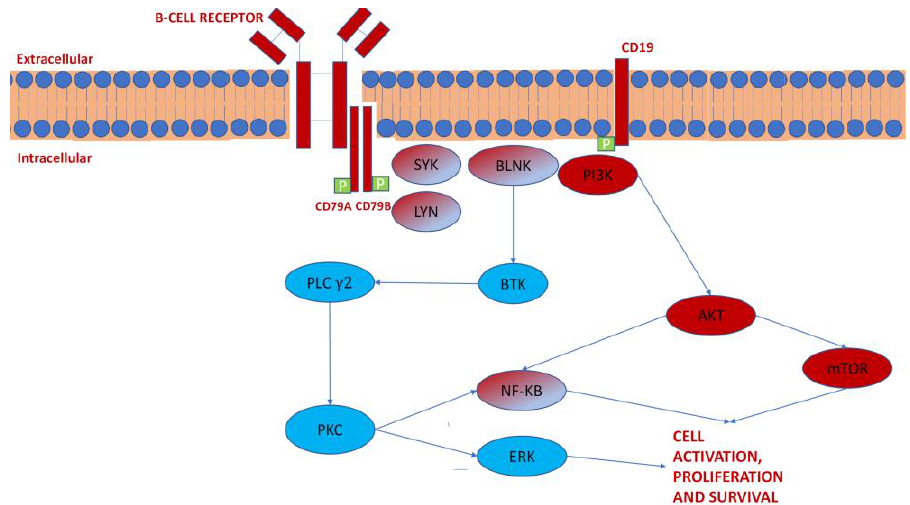
Figure 2. B-cell receptor signaling pathway. Surface B-cell receptor and down-stream signaling proteins participate in pro-sur- vival, proliferation, migration, and apoptosis signals to the CLL cells. Blue indicates the BTK-dependent pathway; red is the PI3K-dependent pathway; red and blue indicate common proteins.